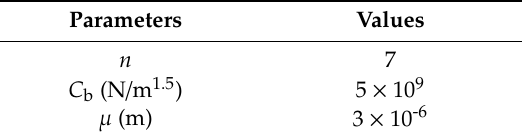
Table A3. The model parameters of ball bearing.